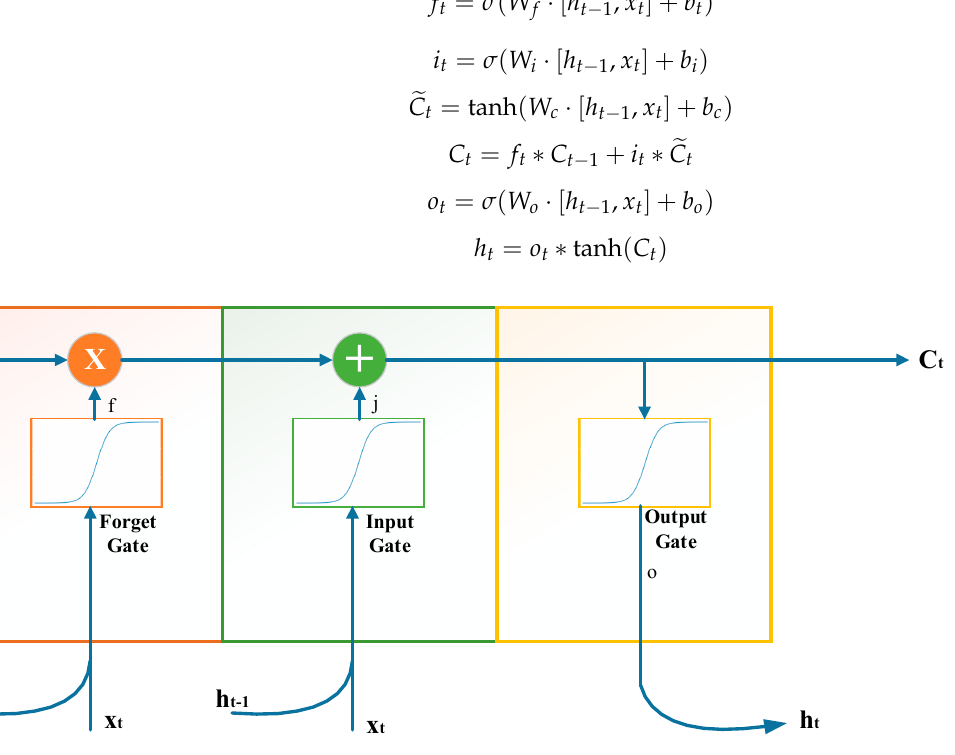
Figure 4. An LSTM Memory Cell.